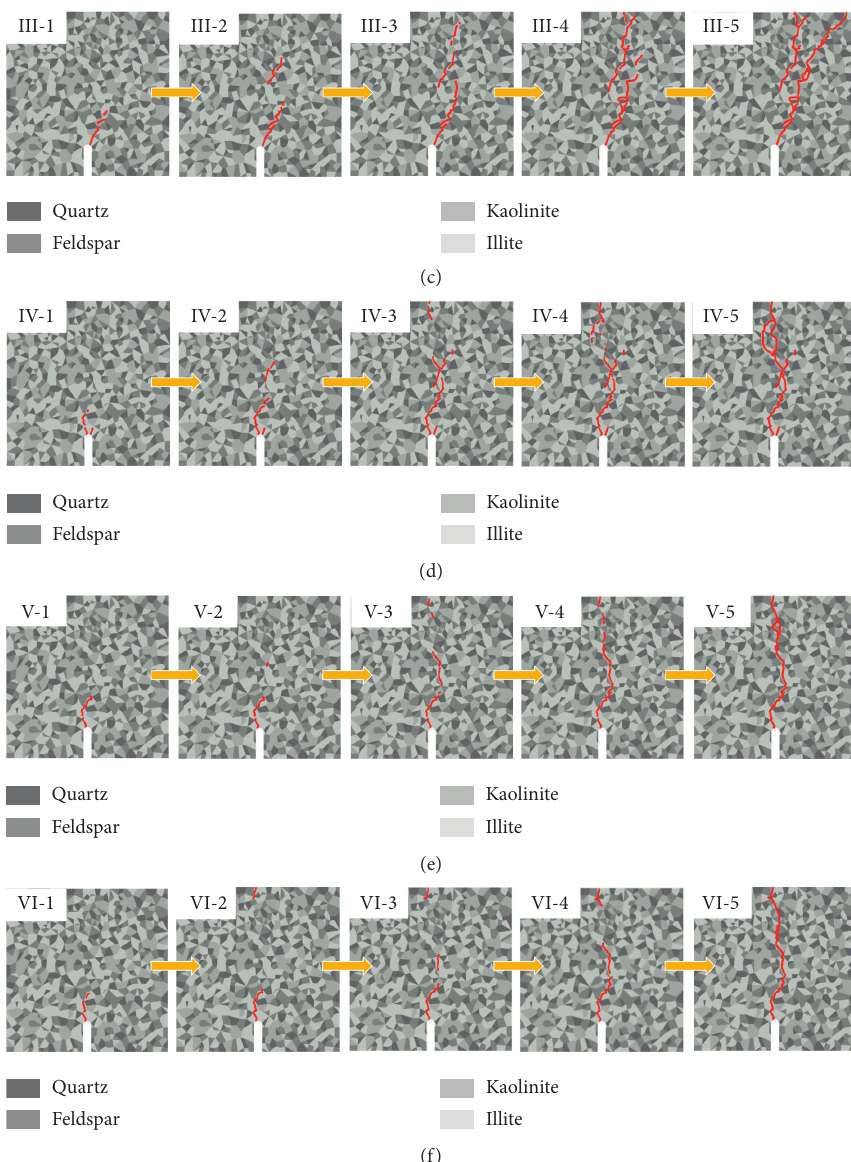
Figure 7: The initiation and evolution of en echelon intermittent fractures under six different loading methods. Every loading method is shown with five figures that demonstrate the growth of en echelon intermittent fractures over